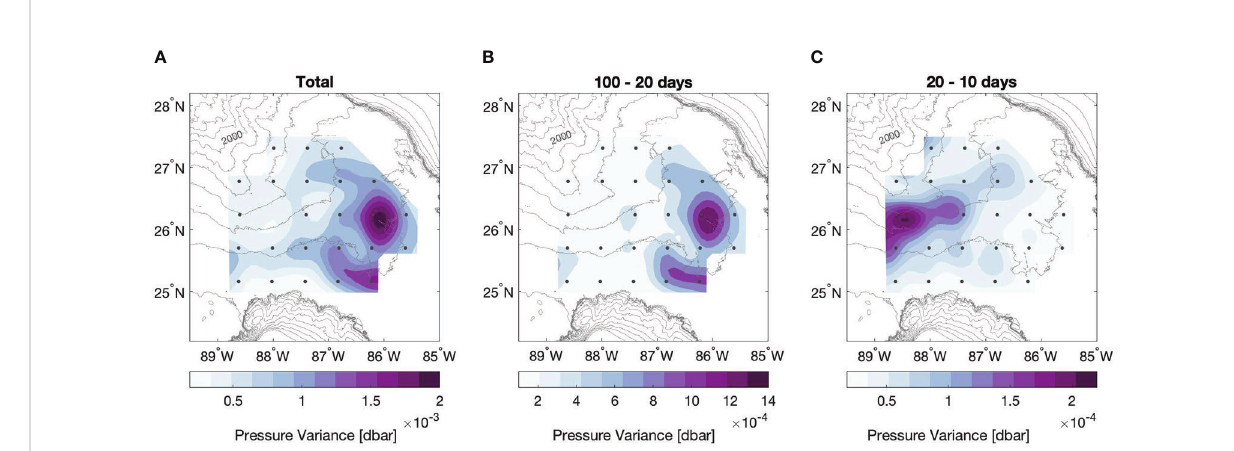
FIGURE 6 Deep pressure variance across all frequency bands (A) , in the 1/100 – 1/20 day – 1 frequency band (B) and in the 1/20 – 1/10 day – 1 frequency band (C) . Variance range is unique to each panel, decreasing from left to right. CPIES locations are marked by black circles and bathymetry is contoured in light gray every 250